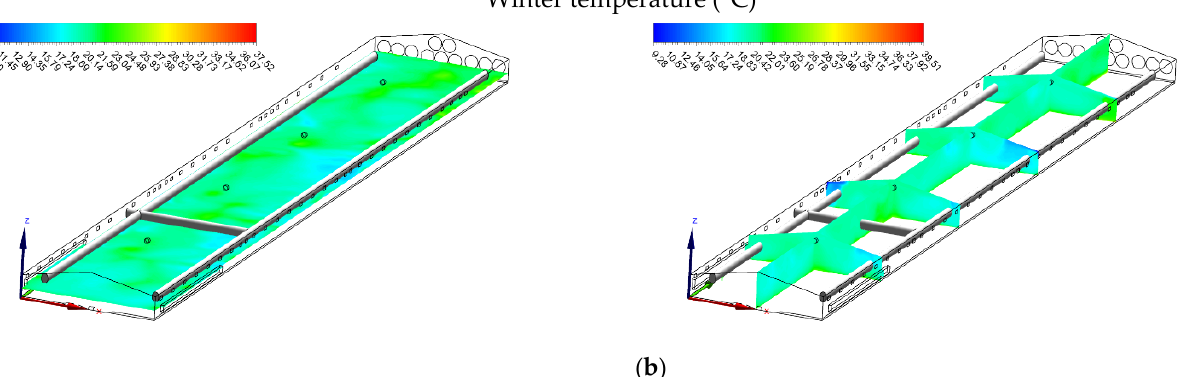
( d ) Figure 9. Temperature (°C) ( a , b ) and airspeed (m s − 1 ) ( c , d ) contours of slice: z = 1 m, and y 1 = 15 m, y 2 = 35 m, y 3 = 55 m, y 4 = 75 m, and x = 7 m in winter when installing circulation fans. 4. Conclusions This study was conducted to simulate the summer and winter microclimates in a mechanically ventilated broiler house. The following conclusions were drawn from the results. Combining field measurements and numerical modeling proved that the applica- tion of CFD facilitated the identification of environmental issues in the broiler house that could affect broilers’ development and simulate effective solutions. In summer, if an evaporative cooling pad system was used, a decrease in tempera- ture of approximately 3 °C could be achieved when the mean air temperature rose above 25 °C in the house. In winter, adding four 500-mm circulation fans of 20-m spacing in- side the house could eliminate the accumulation of hot and humid air in the stagnant zones in the house, resulting in the homogenous spatial distribution of air in the house. This study demonstrated that CFD application in future research might allow more realistic solutions by modeling the conditions under which broilers are reared. Author Contributions: Conceptualization, B.C., and E.K.; methodology, B.C., and E.K.; software, E.K.; validation, E.K., and B.C.; data curation, E.K.; writing—original draft preparation, E.K., B.C., and H.S.; writing—review and editing, H.S., and J.-Q.N., E.K.; visualization, E.K., H.S., and J.- Q.N.; supervision, B.C., H.S., and J.-Q.N.; project administration, E.K., and B.C. All authors have read and agreed to the published version of the manuscript. Funding: This research was funded by the Scientific and Technological Research Council of Tur- key, TUBITAK (215O650), and the Ondokuz May ı s University Scientific Research Projects De- partment (PYO.ZRT.1901.18.018). Institutional Review Board Statement: Not applicable .